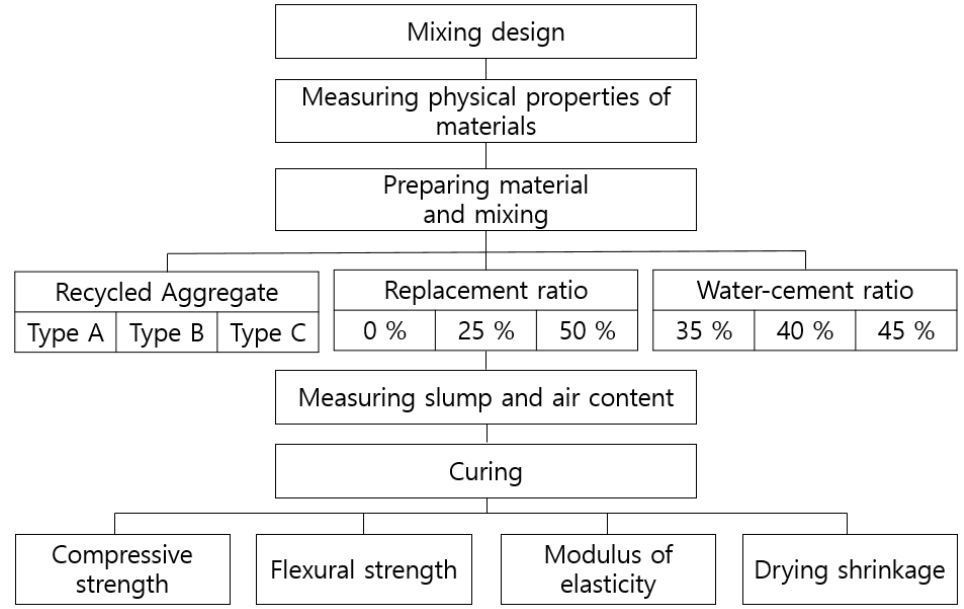
Figure 1. Flow chart for concrete experiment.